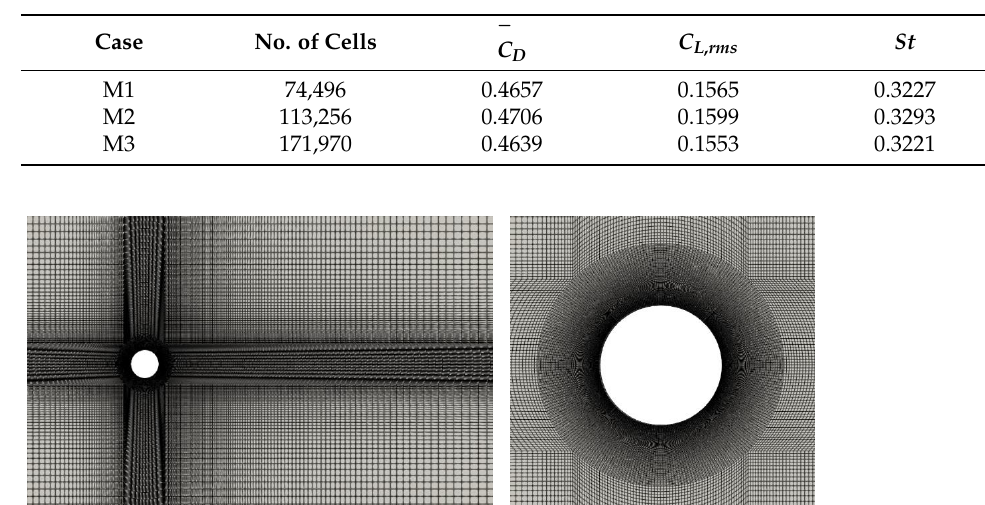
Table 1. Results of grid convergence study.